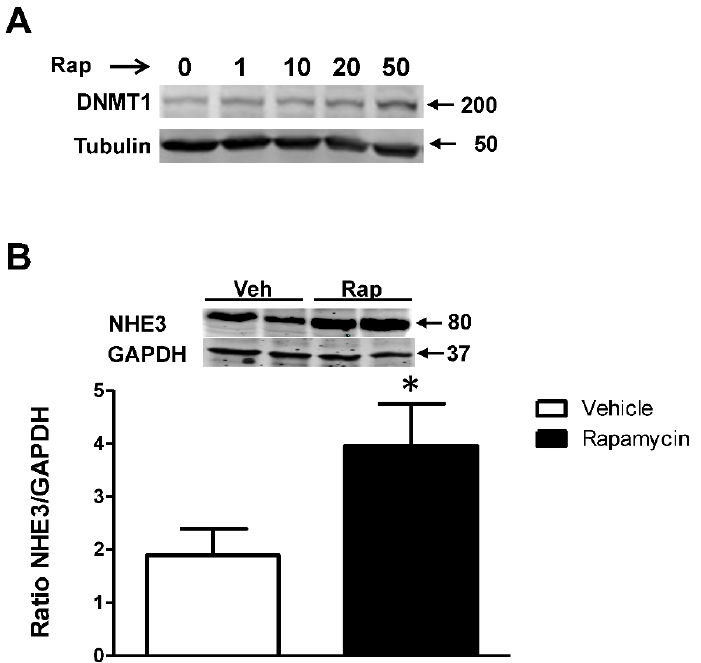
Figure 9. Rapamycin treatment increases DNMT1 and NHE3 expression in hRPTCs. Cells were treated with rapamycin at the concentrations of 1, 10, 20, and 50 nM or vehicle for 24 h. The expression of DNMT1 was determined by Western blot. Quantification was normalized by tubulin expression. The molecular size markers are indicated on the left. Another set of hRPTCs were treated for 24 h with 50 nM rapamycin or vehicle, and the expression of NHE3 of the cell lysates was determined by Western blot. Quantification was normalized by GAPDH. The molecular size markers are indicated on the left. n = 3/group * p < 0.05 vs. vehicle.